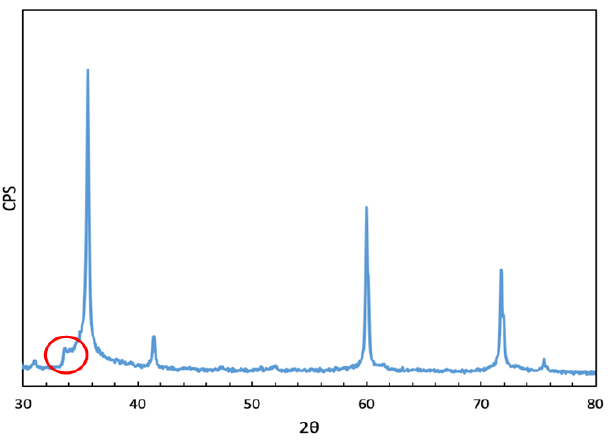
Figure 3. Diffractogram pattern of beta-SiC. The circle indicates a shoulder that is associated with defects, which appears as a shoulder at the peak (1,1,1).